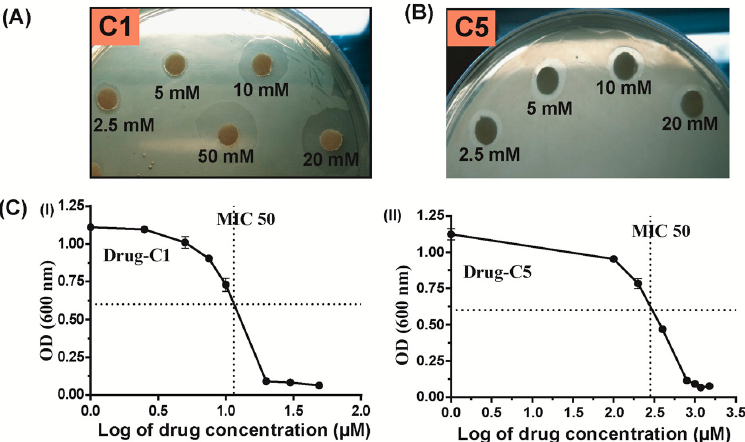
Figure 6. Antimicrobial activities of different drugs against H. pylori . ( A ) Anti- H. pylori activities of different drugs ( A ) 5-chloroisatin (C1) and ( B ) 3,4-difluorobenzamide (C5) determined by applying the disk diffusion method. Petri dish with drugs containing discs showed inhibition zones for bacterial growth; ( C ) Anti- H. pylori activities of drugs determined as minimum inhibitory concentrations (MICs) were obtained via the dilution method. The MIC of drug C1 and C5 are 18 µM and 824 µM, respectively. The experiments were performed in triplicates. Error bars show standard deviation of the mean (Mean ± SD).